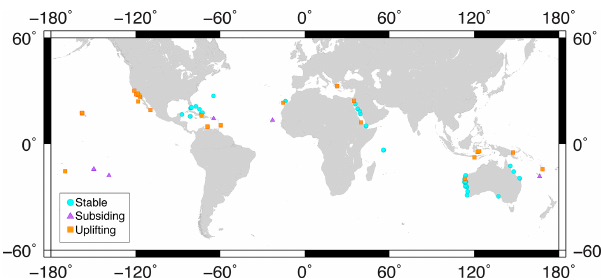
Figure 1. Site map of U-series-dated fossil corals compiled for this study. Sites are differentiated based on regional tectonic setting, with stable sites marked with a cyan circle, subsiding sites with a purple triangle and uplifting sites with an orange square. Map cre- ated using GMT v5.4.5 (Wessel et al.,